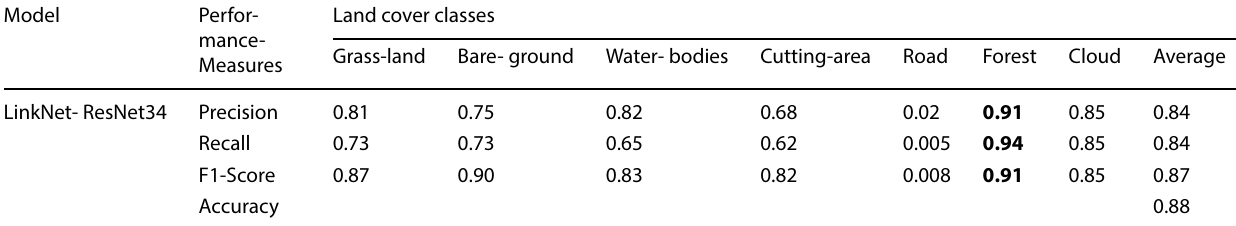
Table 4 Summary of Performance Measures for LinkNet-ResNet34 Model